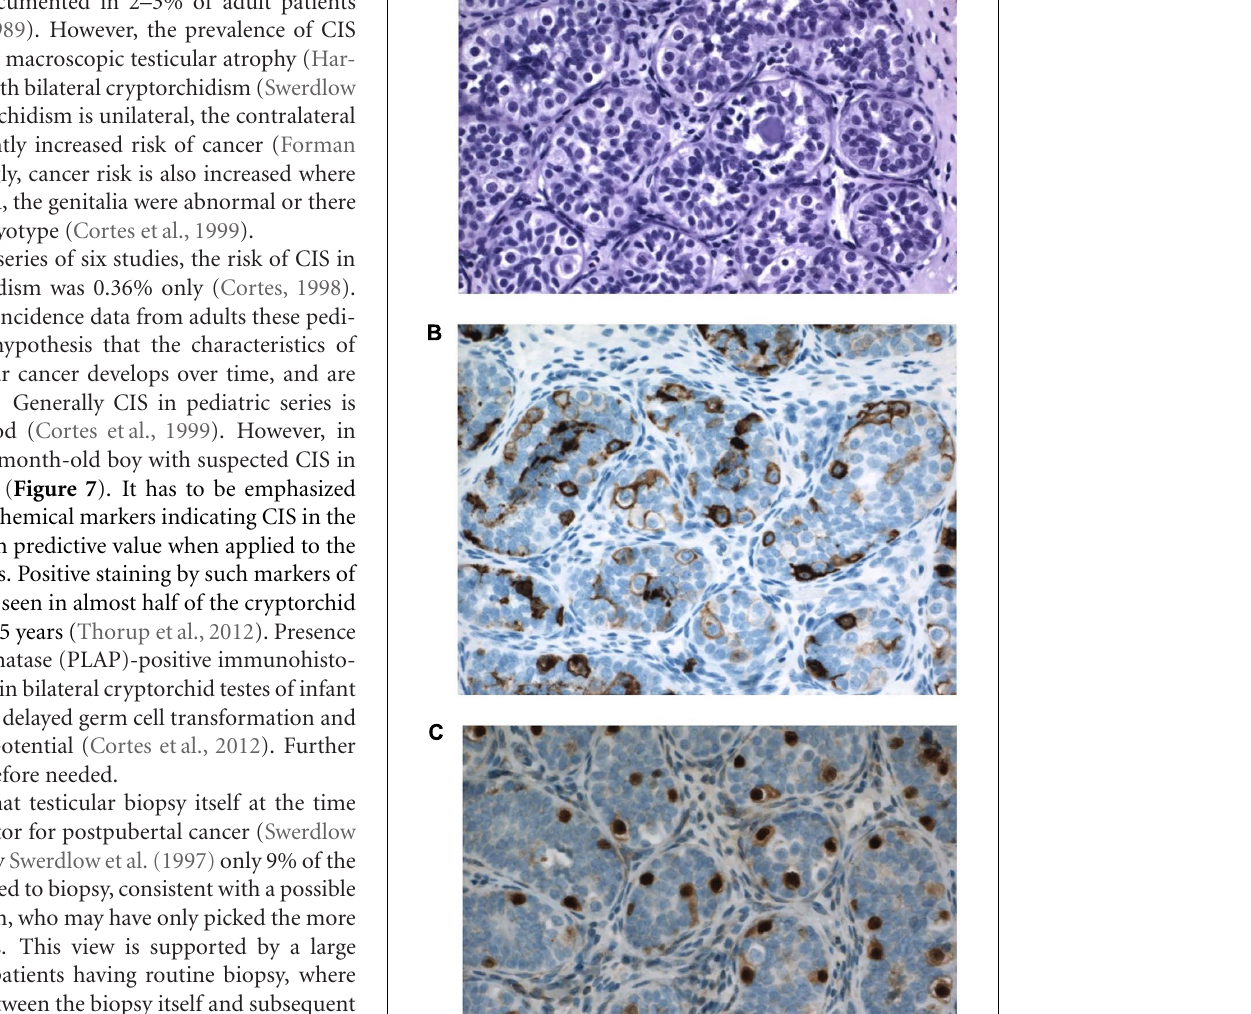
surgery in these follow-up studies averaged more than 2